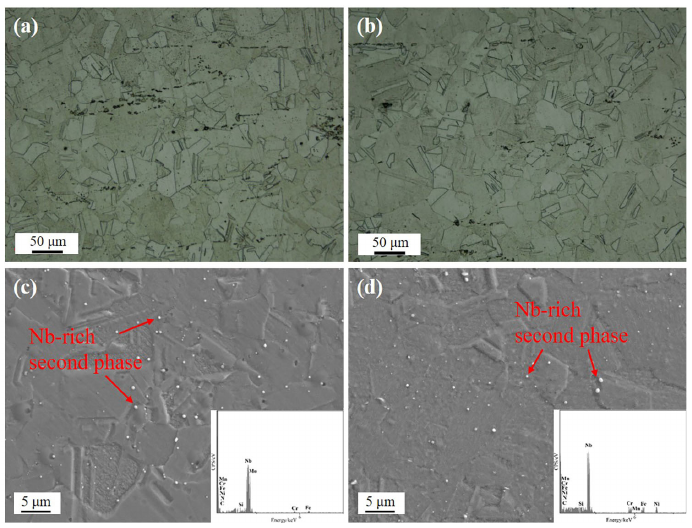
Figure 1. Microstructures of the 20Cr-25Ni-Nb samples: ( a , b ) OM and ( c , d ) SEM images of samples S1 and S2, respectively.